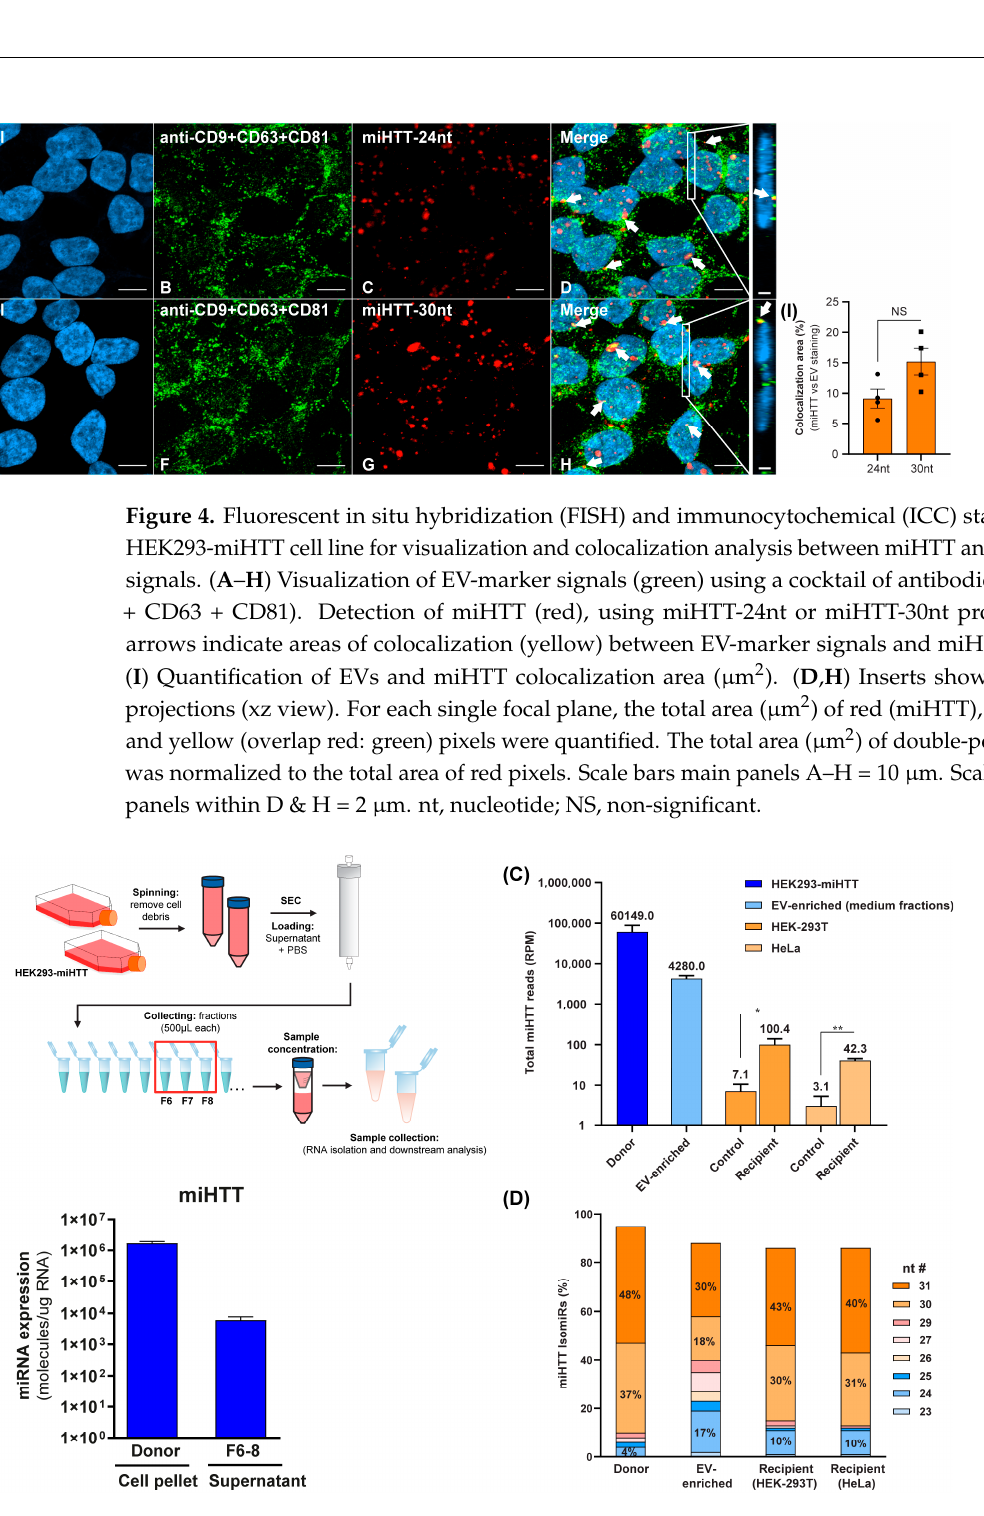
Figure 5. Small RNA sequence analysis reveals different miHTT isomiR profiles in donor cells, recipient cells, and EV-enriched medium fractions. ( A ) Schematic depicting the EV isolation and enrichment process. ( B ) miHTT detection (by RT-qPCR) in donor cell pellets and in EV-enriched cell culture medium fractions (F6-8) isolated by size exclusion chromatography. ≥ N = 6 repeats per experimental condition. ( C ) Total RNA sequencing reads were performed on samples from the contactless co-culture study; HEK293-miHTT donor cells, HEK-293T and HeLa recipient cells, and EV-enriched supernatant. N = 3 repeats per experimental condition. ( D ) Percentage of miHTT isomiRs (assessed using small RNA sequencing) in samples from the contactless co-culture study; HEK293-miHTT donor cells, HEK-293T, and HeLa recipient cells. N = 3 repeats per experimental condition. nt #, nucleotide number; RPM, reads per